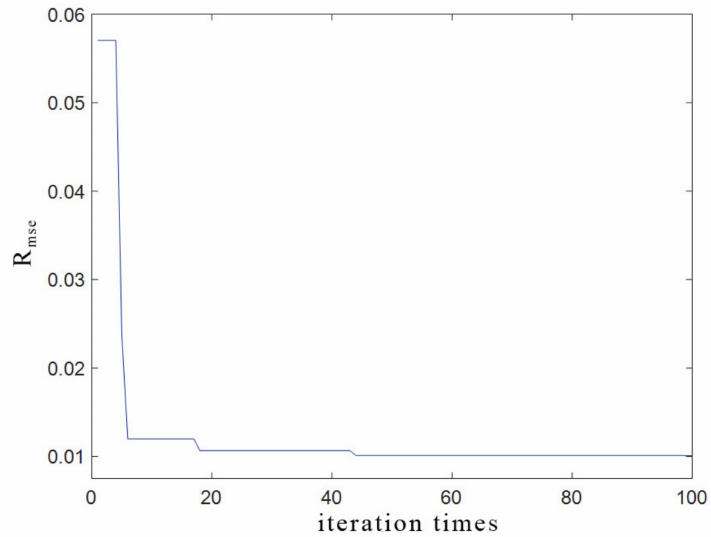
Figure 3. Fruit fly optimization algorithm (FFOA) optimization